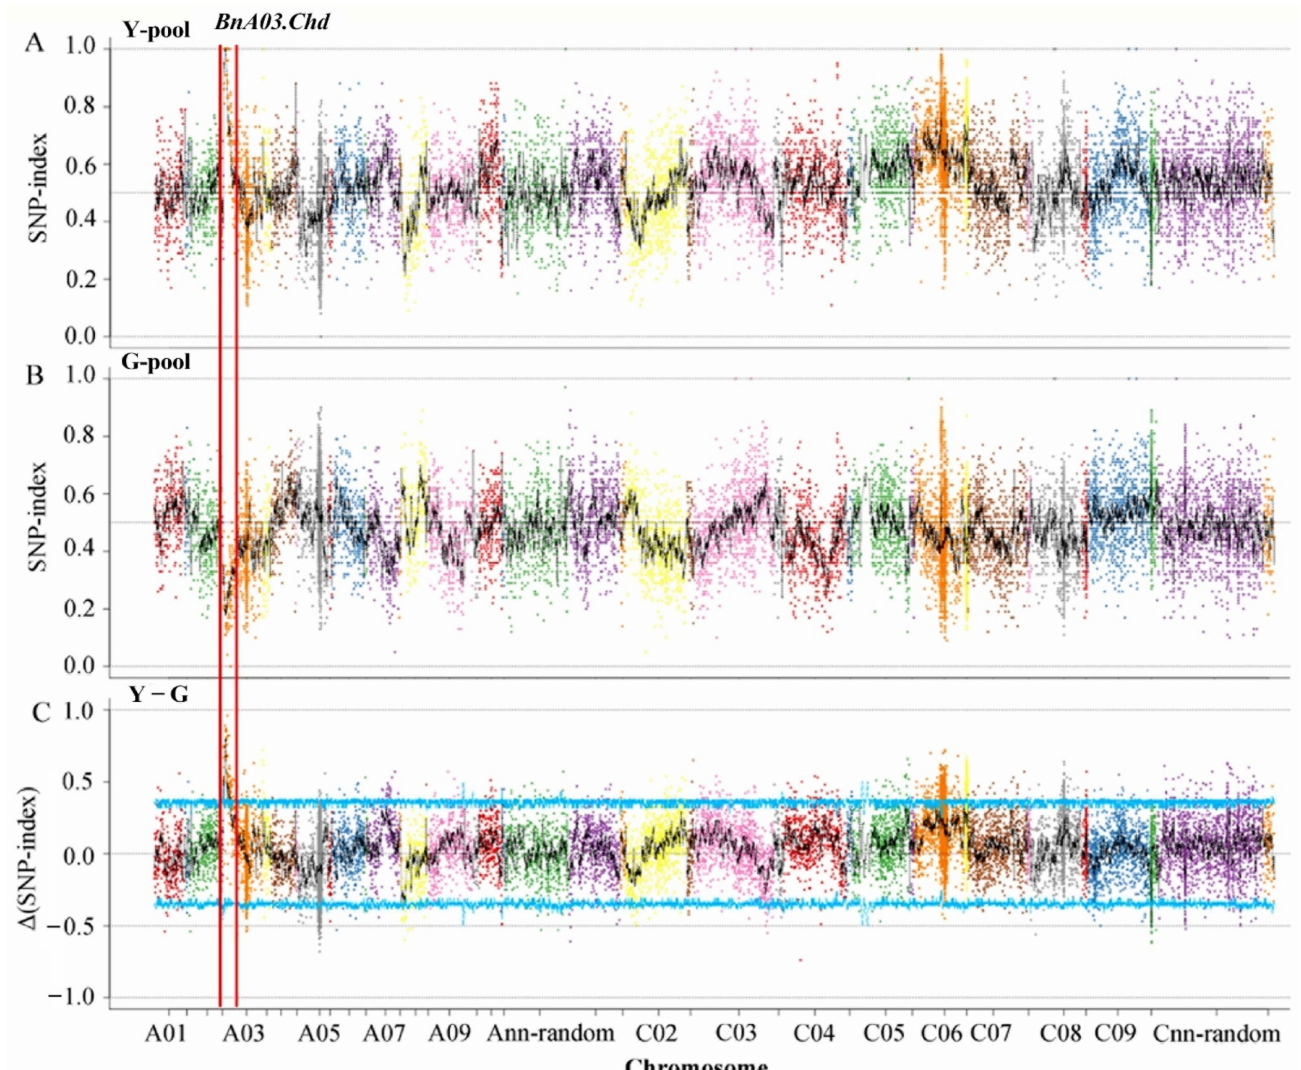
Figure 2. SNP-index and ∆ (SNP-index) graphs from the QTL-Seq analysis. SNP-index of ( A ) Y-pool (homozygous mutant leaves) and ( B ) G-pool (wild-type leaves); ( C ) ∆ (SNP-index) of Y-pool and G-pool. The BnA03.Chd on chromosome A03 was regarded as the candidate interval, with an α = 0.05 significance